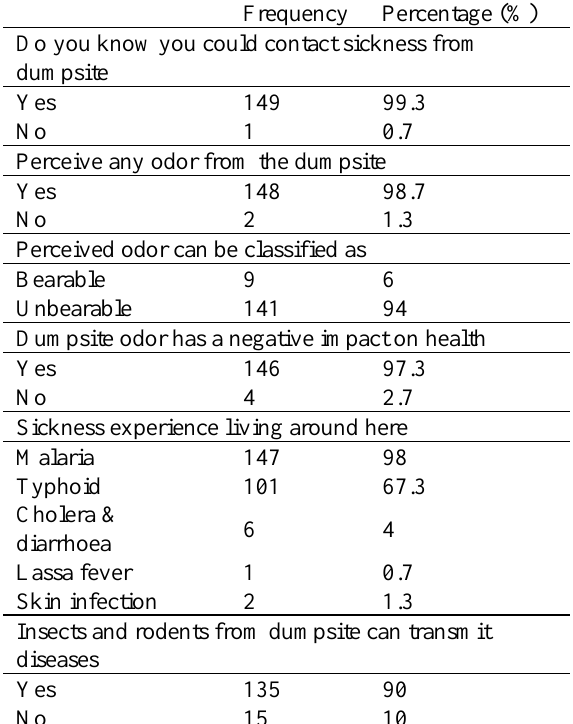
Table 3. Perception of respondents on hazards of living near dumpsite